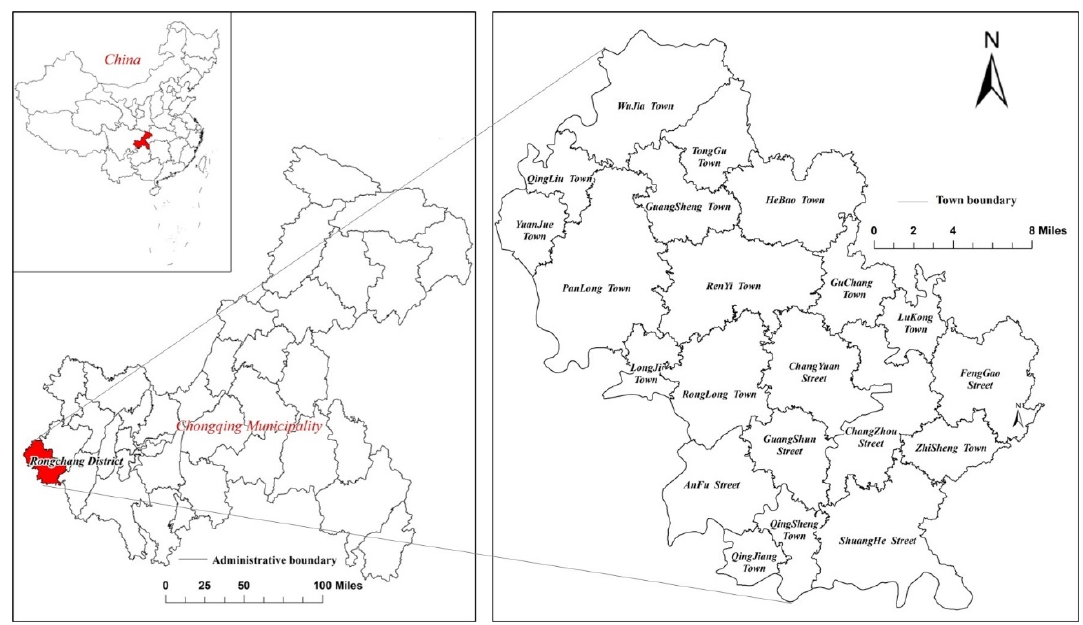
Figure 1. Location of Rongchang District. Table 1. Change in land-use structure in Rongchang District, 2009–2015, and the planning control target in